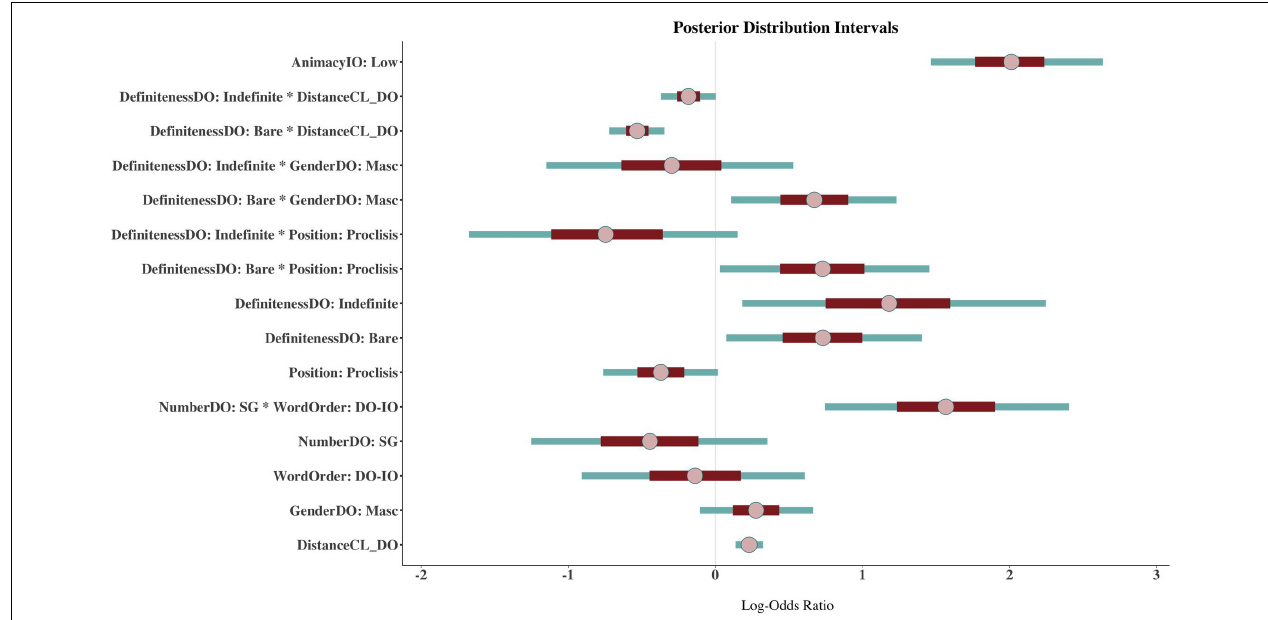
FIGURE 6 | Posterior distribution intervals of the Bayesian mixed-effects model. The pink dot represents the mean, the red inner line and the teal line the 95 and 50% credible intervals, respectively.